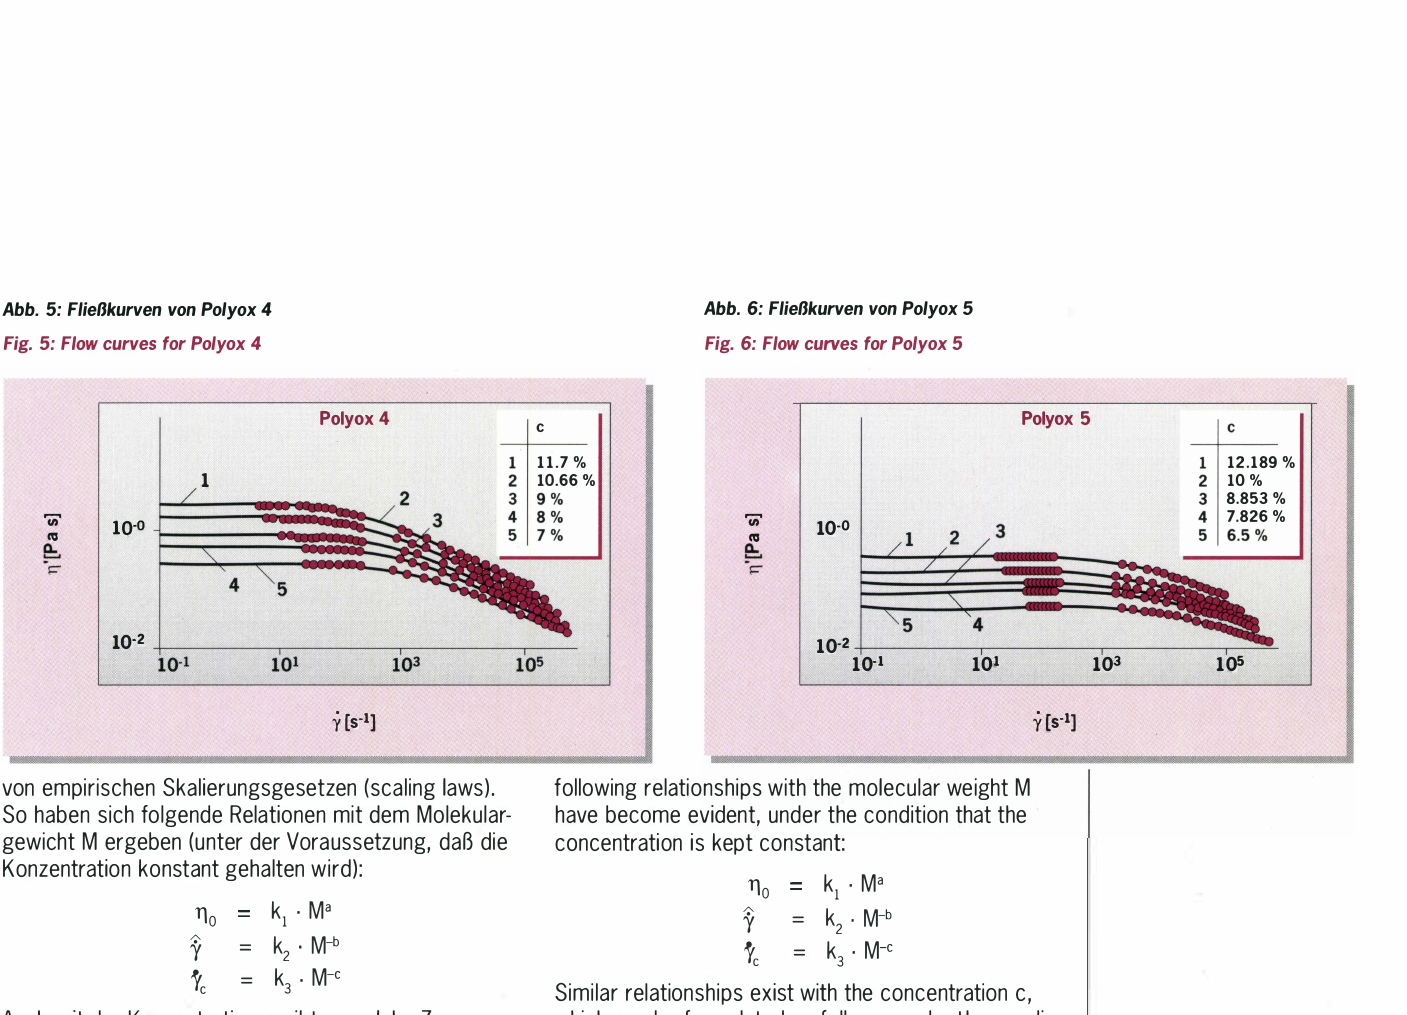
Fig. 5: Flow curves for Polyox 4 Fig. 6: Flow curves for Polyox